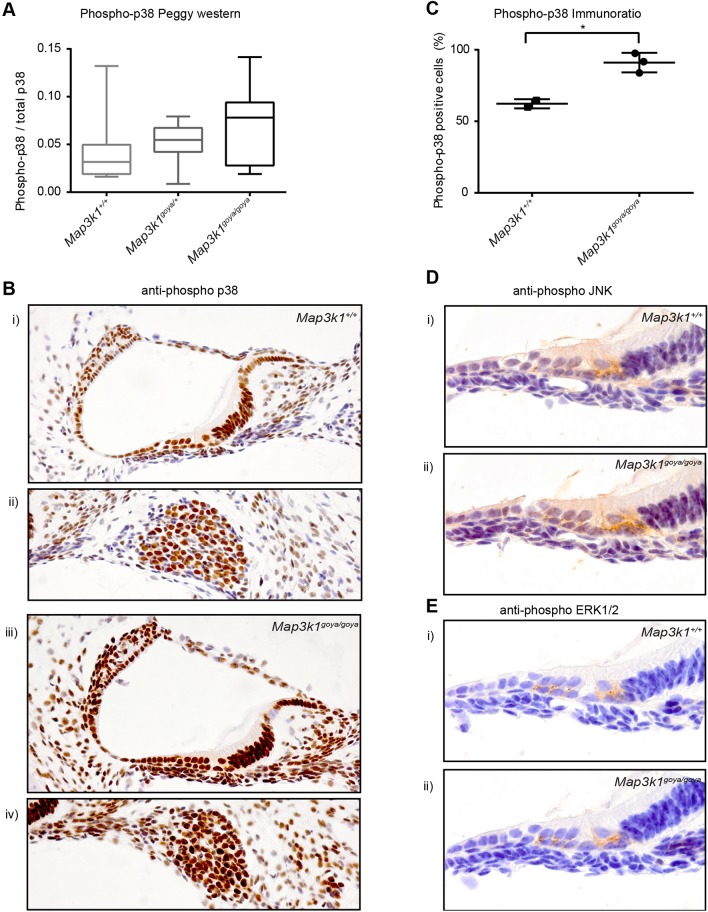
The inner ears of P1 Map3k1goya/goya mice exhibit increased levels of p38 phosphorylation. (A) Box plot of the ratio of phosphorylated p38 to total p38 in goya inner-ear total protein lysates from Map3k1+/+, Map3k1goya/+and Map3k1goya/goya mice. Three ears (one each from separate mice) were pooled for each lysate (number of lysates: Map3k1+/+n=8, Map3k1goya/+ n=7, Map3k1goya/goya, n=8). A trend of increased p38 phosphorylation is observed in Map3k1goya/goya inner-ear lysates when compared to Map3k1+/+ (P=0.282). Average Map3k1goya/+ p38 phosphorylation levels are intermediate between Map3k1+/+ and Map3k1goya/goya. (B-E) Immunohistochemical analysis of P1 Map3k1goya/goya cochlea confirms the increased level of p38 phosphorylation observed in the Peggy Western data. Panels Bi and iii show phosphorylated p38 expression in the mid turn of the cochlea of P1 Map3k1+/+ (i) and Map3k1goya/goya (iii) mice. Widespread nuclear expression is seen in both genotypes; however, the depth of staining is greatly increased in Map3k1goya/goya. Some nuclei in spiral ligament, spiral limbus and basilar membrane in the Map3k1+/+ organ of Corti remained unstained with this length of chromogenic exposure. These results were consistent for littermate controls (Map3k1+/+ n=2, Map3k1goya/goya n=3). (C) Immunoratio was used to quantify the percentage of nuclei stained in each mid turn image. This analysis showed that the Map3k1goya/goya mice (n=3) had significantly increased numbers of positively stained cells when compared to Map3k1+/+ (n=2). Bii and iv show increased positive staining for phosphorylated p38 in the spiral ganglion neurons of Map3k1goya/goya (iv) mice compared to Map3k1+/+ (ii). (D,E) Immunostaining of P1 organ of Corti using anti-phospho JNK and anti-phospho ERK1/2 antibodies, respectively. No differences can be seen between Map3k1+/+ (Di,Ei) or Map3k1goya/goya (Dii,Eii) mice, although, interestingly, expression of both proteins is mainly observed below the basal surface of inner and outer hair cells, in contrast to the widespread nuclear expression of phosphorylated p38.